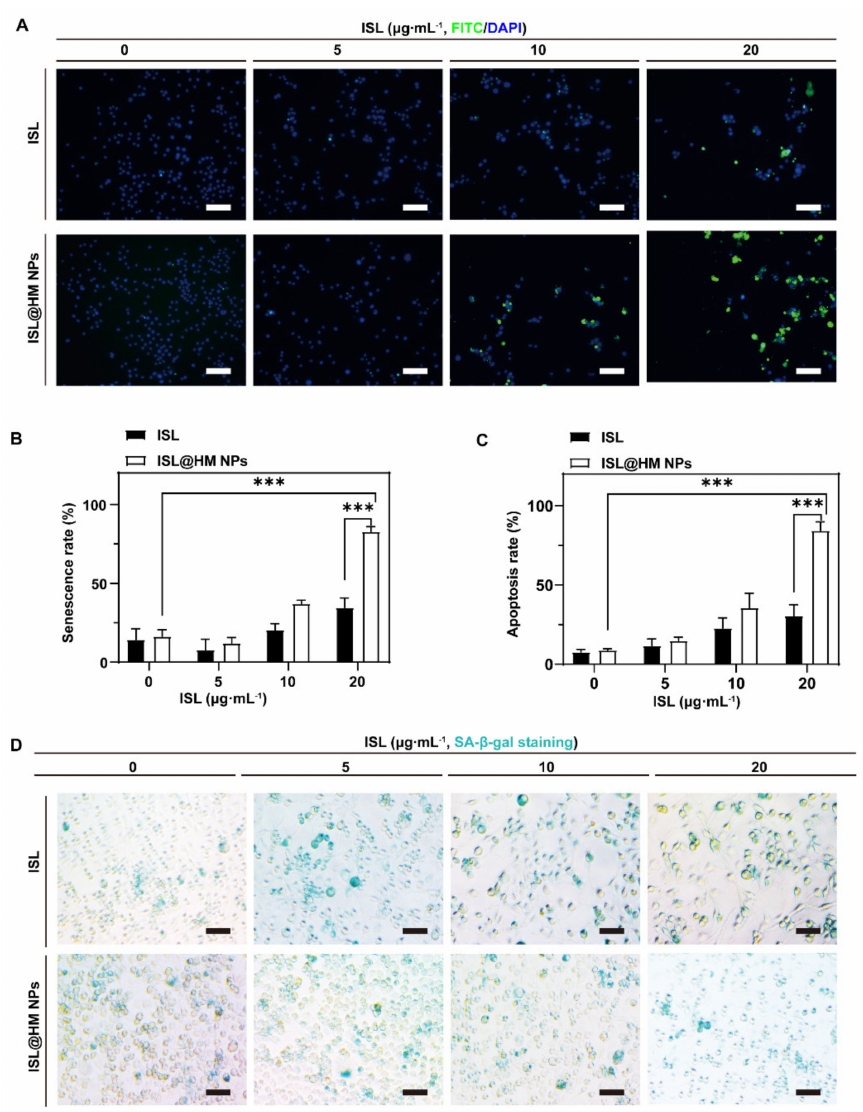
Figure 4. Fluorescence images ( A ) and quantitative assay ( B ) of TUNEL staining after different treatments with U251 cells (scale bar = 50 µ m). Fluorescence images ( D ) and quantitative assay ( C ) of β − Galactosidase staining after different treatments with U251 cells (scale bar = 50 µ m). ( n = 3; mean ± s.d. *** p < 0.001, as determined by unpaired, two − tailed Student’s t -tests. n refers to biological